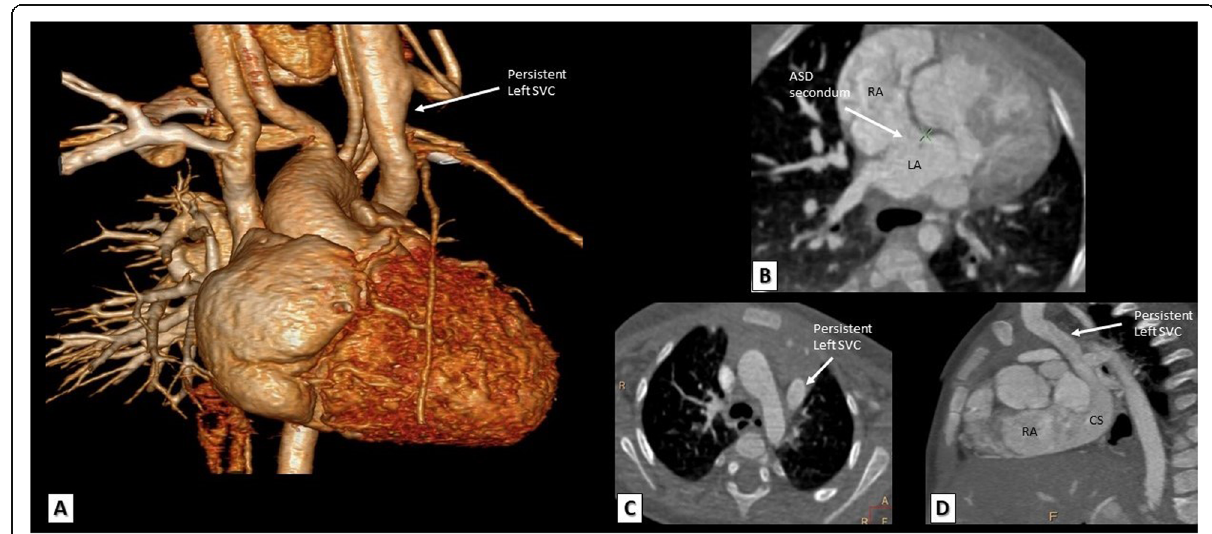
Fig. 6 a A 3D VRT. b , c Reformatted axial and d reconstructed sagittal MDCT images. This TOF patient has an associated ostium secondum ASD ( b ) in addition to persistent left superior vena cava draining into the coronary sinus ( a , c , d ). ASD, atrial septal defect; SVC, superior vena cava; RA, right atrium; CS, coronary sinus; LA, left